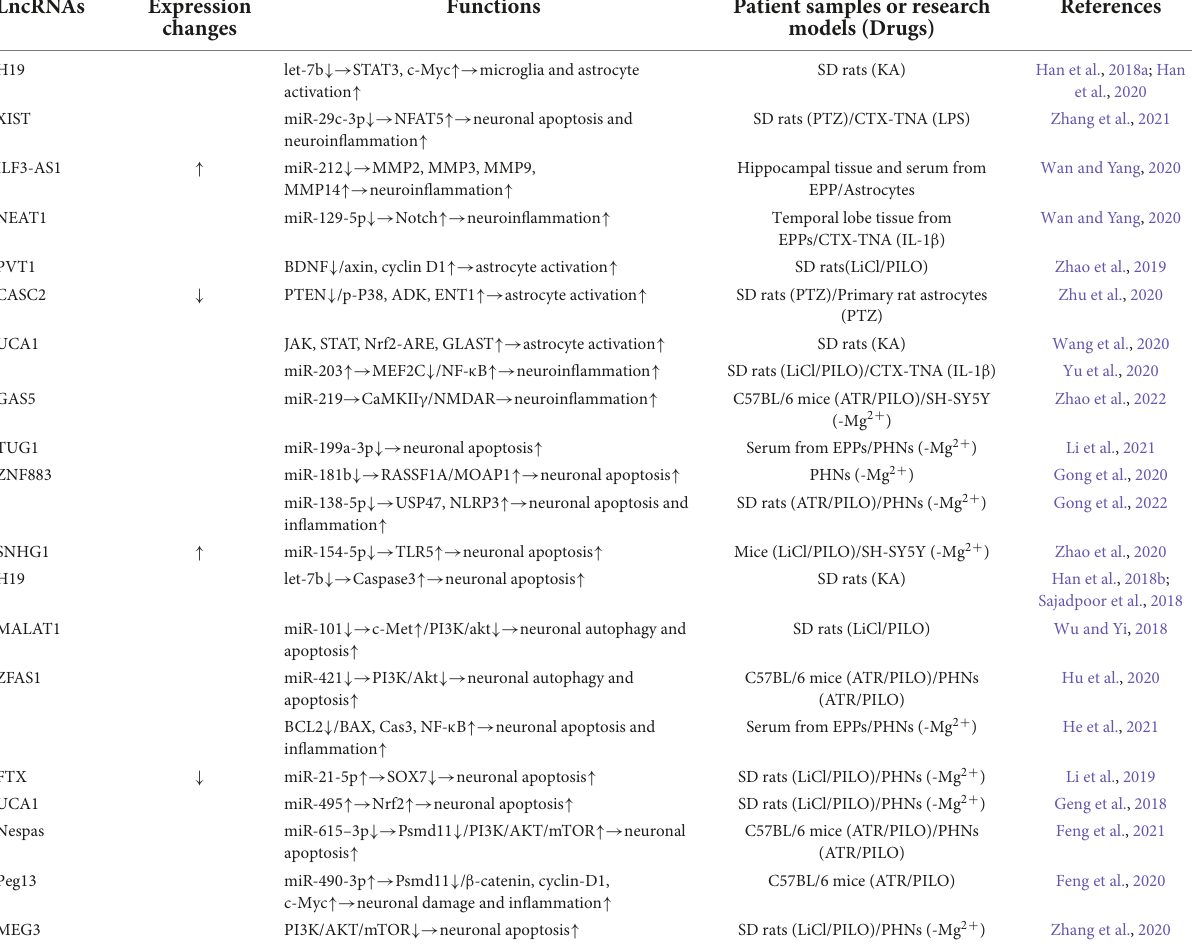
TABLE 1 The pathways of LncRNAs involved in the pathogenesis of